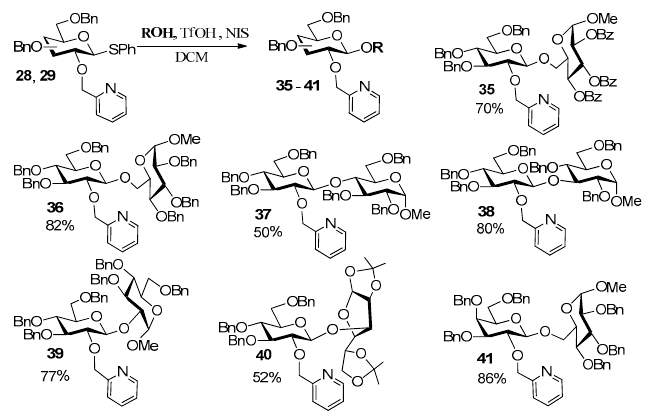
Figure 7. Application of this method in glycosylation.